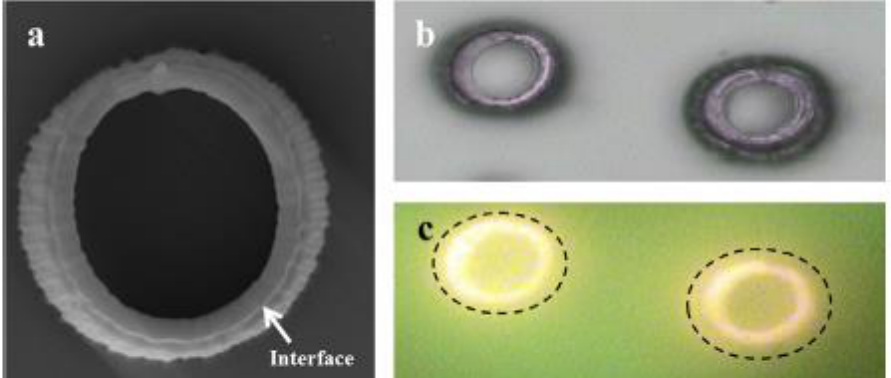
Figure 7. ( a ) SEM and ( b ) optical image (top view) of the cylindrical microstructures (the external diameter of the cylinder is 30 μm with a thickness of 5 μm), displaying the interface between the cylindrical shells. ( c ) Fluorescence image of the microstructure upon excitation with an LED centered at 450 nm. The contour of the undoped region is represented by the dotted line. Reprinted with permission from [59]. Copyright (2014), Materials Research.